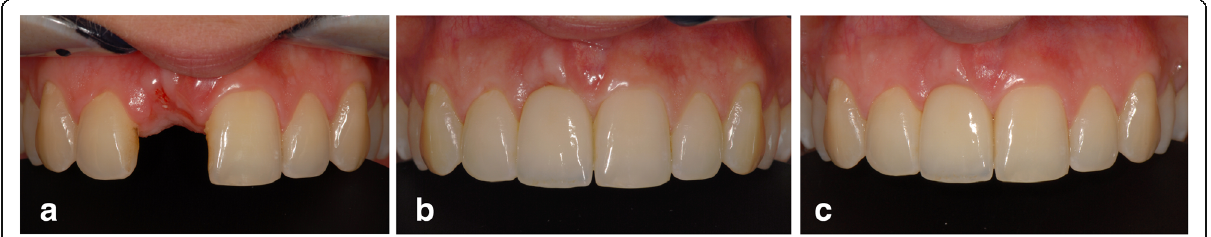
Fig. 2 Soft tissue changes. a Pre-implant situation. b One month after definitive restoration placement. c Twelve months after definitive restoration placement